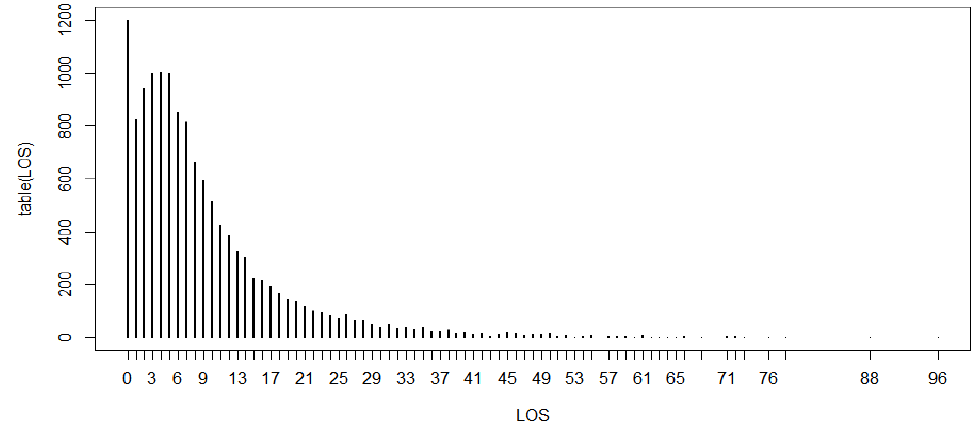
Figure 2. Frequency distribution of LoS.